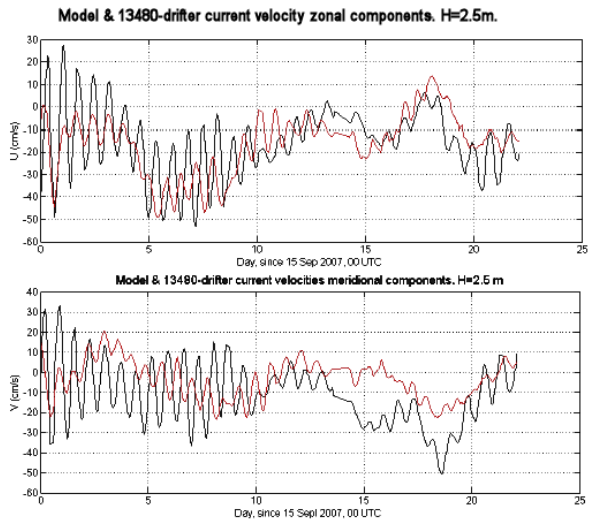
Figure 15 Comparison of the measured (black) and simulated (red) inertial oscillations. Fig. 15. Comparison of the measured (black) and simulated (red) inertial